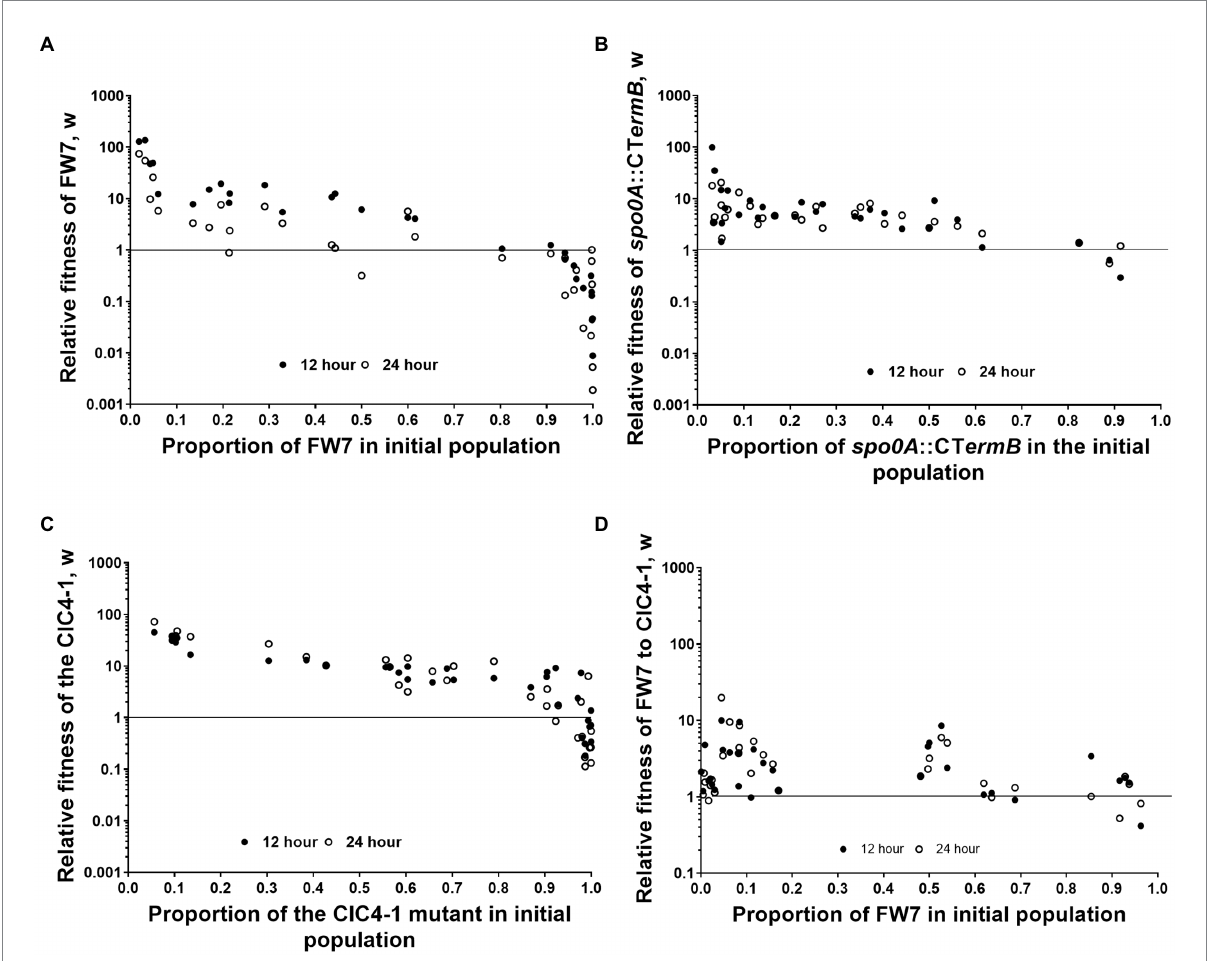
FIGURE 4 Fitness assays between WT and derived mutants. Frequency-dependent assay of (A) FW7 vs. WT, (B) spo0A::CTermB vs. WT, (C) CIC4-1 vs. WT, and (D) FW7 vs. CIC4-1. Data points represent individual mixed cultures. Solid circles are 12 h values and empty circles are 24 h values. n =